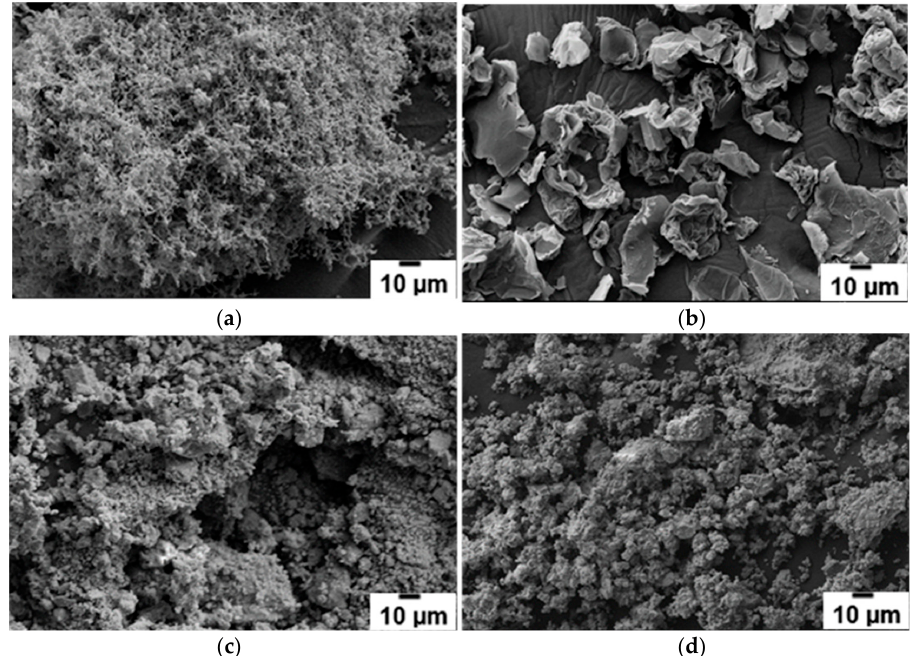
Figure 1. Scanning electron micrographs (SEM) of ( a ) as-received ultrafine filamentary Ni; ( b ) as-received graphene (flake-reduced graphene oxide-(FL-rGO)); ( c ) 1 h BM ((2NaBH 4 + MnCl 2 ) + 5 wt. % Ni) mixture and ( d ) 0.5 h BM ((NaBH 4 + MnCl 2 ) + 5 wt. % graphene) mixture.